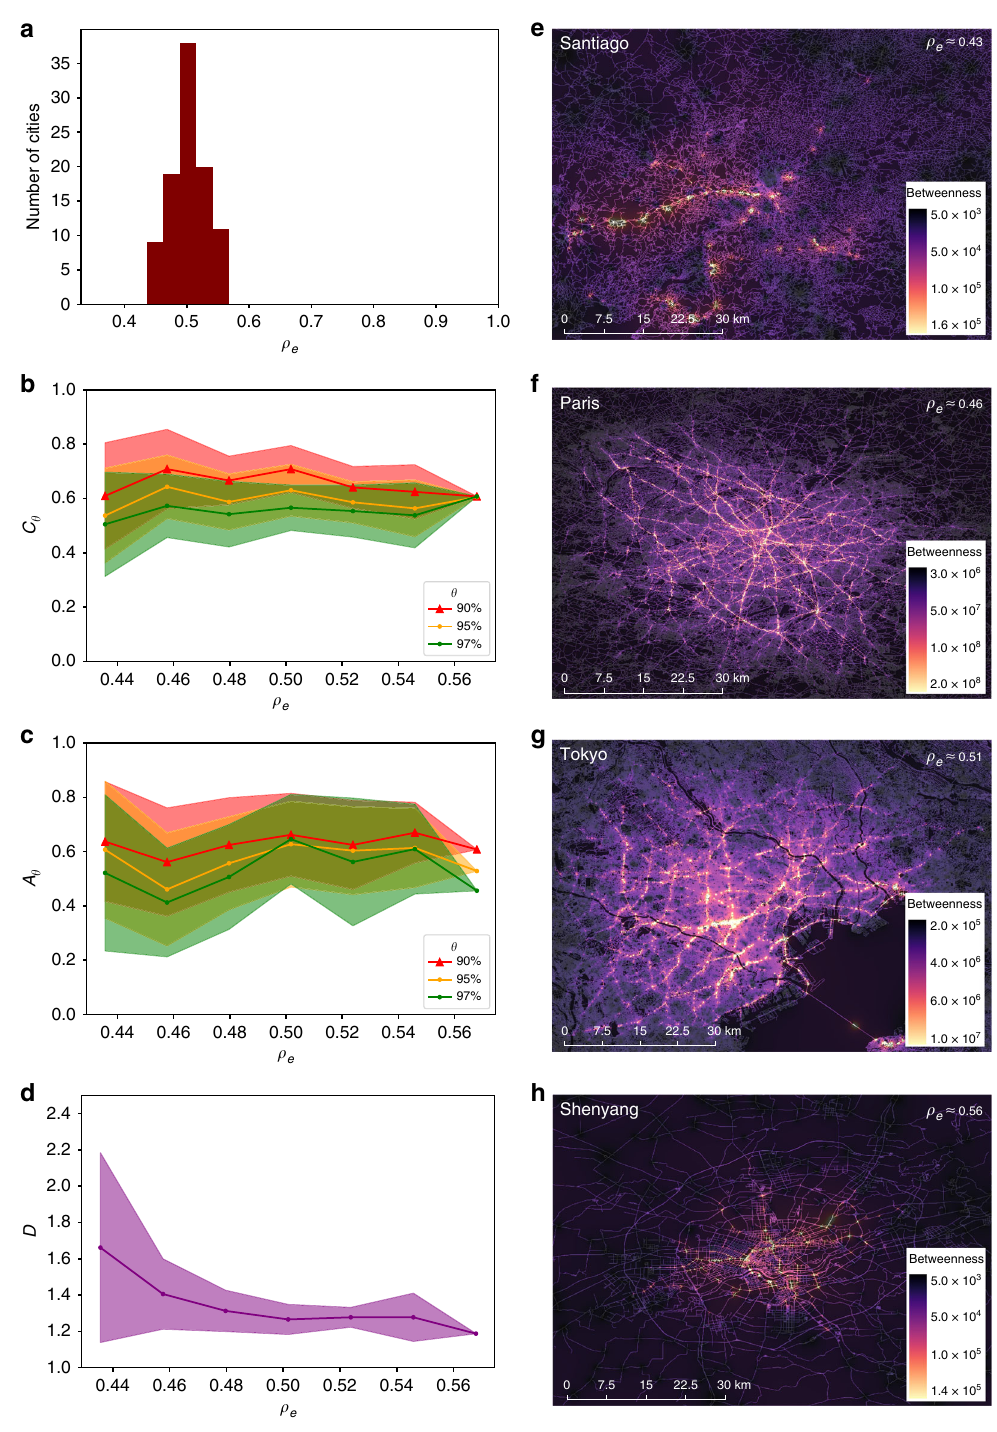
Fig. 5 Spatial behavior of high betweenness nodes in cities. a Distribution of edge-densities for the 97 cities lie in a narrow range 0.4 ≤ ρ e ≤ 0.6 with most cities peaked at ρ e ≈ 0.5. b Variation of the spatial clustering 〈 C θ 〉 and c anisotropy ratio 〈 A θ 〉 with ρ e for the same range of thresholds used for the random graph models. d Detour factor for the full street network across cities plotted according to their edge-density. Points are averages over cities within a bin- size of ρ e = 0.02 and the shaded areas represent the fl uctuations within the bins. Fluctuations arise due to a combination of smaller samples compared to those generated in our random graph simulations, as well as the averaging over cities with the same edge-density but different N . e – h Spatial layout of intersections in four representative cities in increasing order of ρ e . The color scale goes from purple to yellow with increased BC. The functional trends of the metrics and the geospatial patterns for the cities are consistent with what is observed for the random graph model described in the